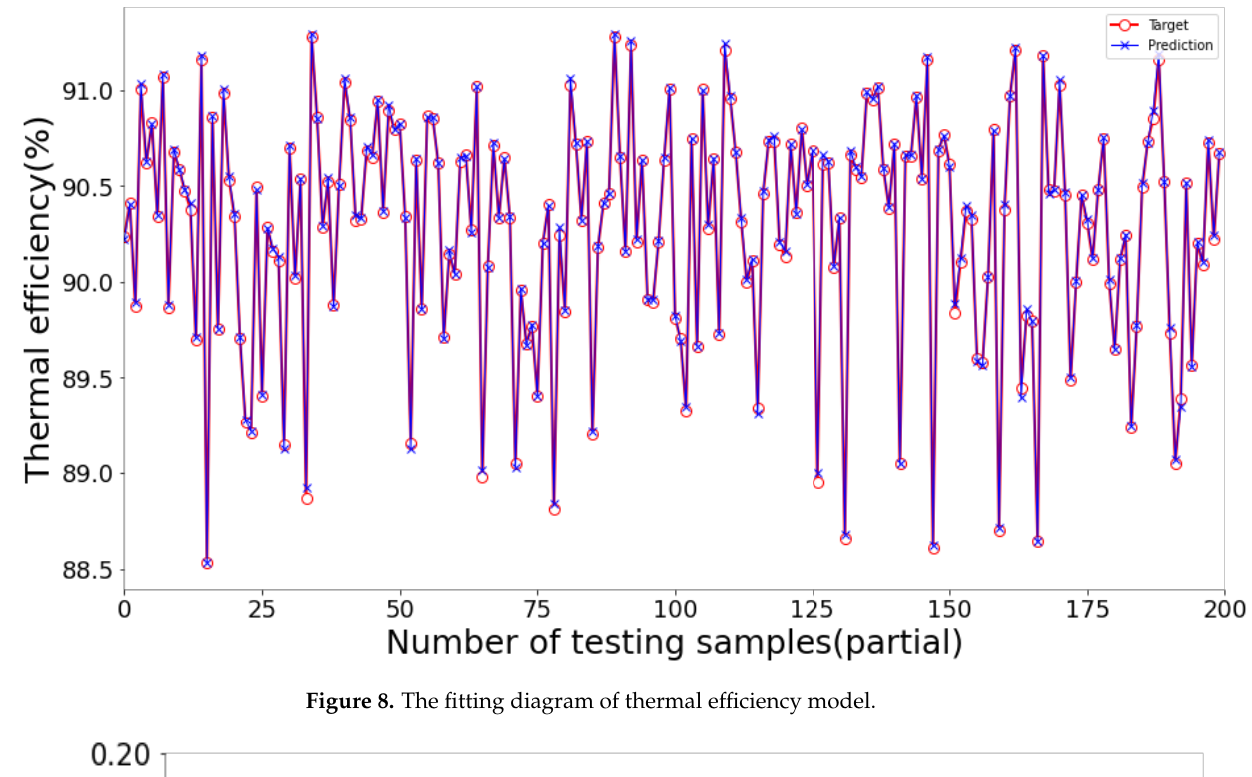
Figure 8. The fitting diagram of thermal efficiency model.